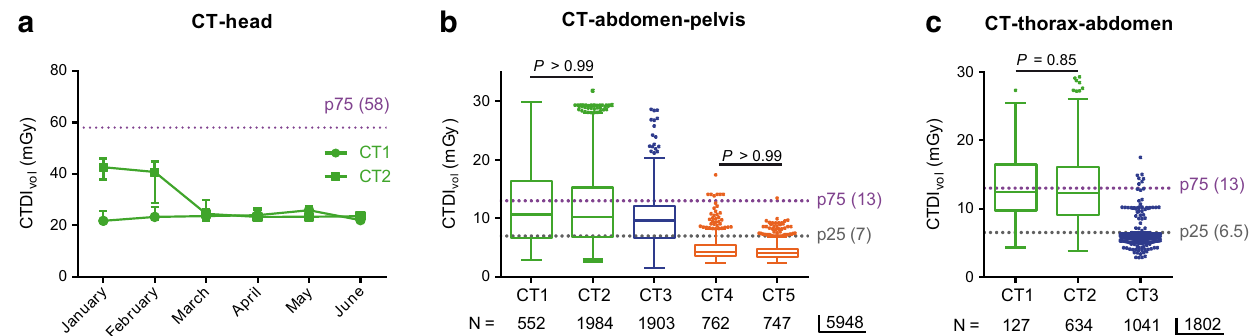
c Box plot of the CTDI vol -median value, interquartile range, total range and outliers for all CT-thorax-abdomen examinations on three CT systems with the national P75 and P25 DRLs as benchmark, demonstrating median CTDI vol levels between both CT systems in hospital A and between both CTsystems in hospital C are not different. Kruskal-Wallis test with post-hoc Dunn test. Adjusted p values not shown on the graph are